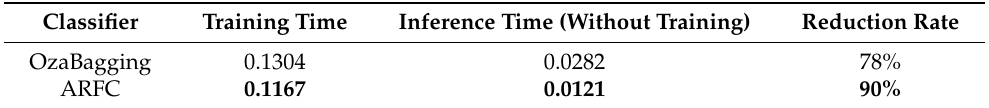
Table 6. Comparison of the response time’s reduction in seconds between ARFC and OzaBagging in edge node.